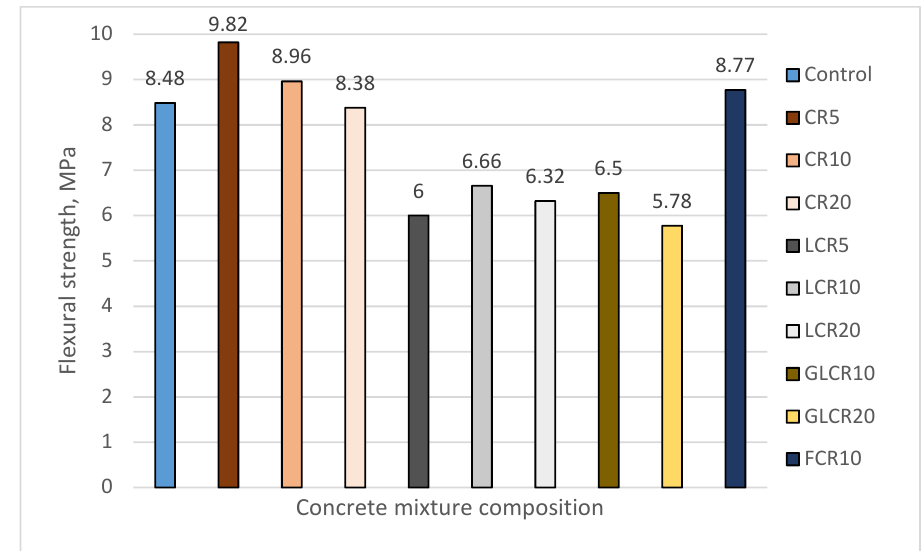
Figure 3. The change in flexural strength of concrete.